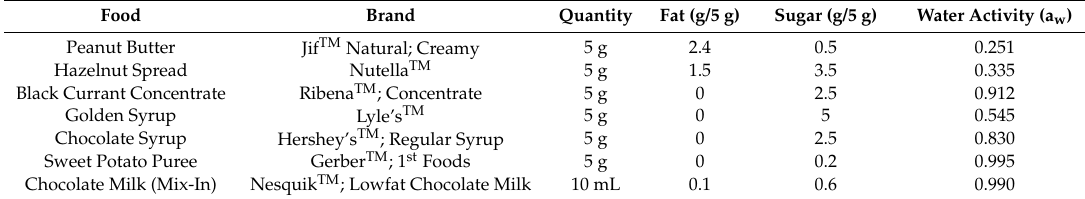
Table 2. Composition and physical characteristics of model foods selected as dosing vehicle or